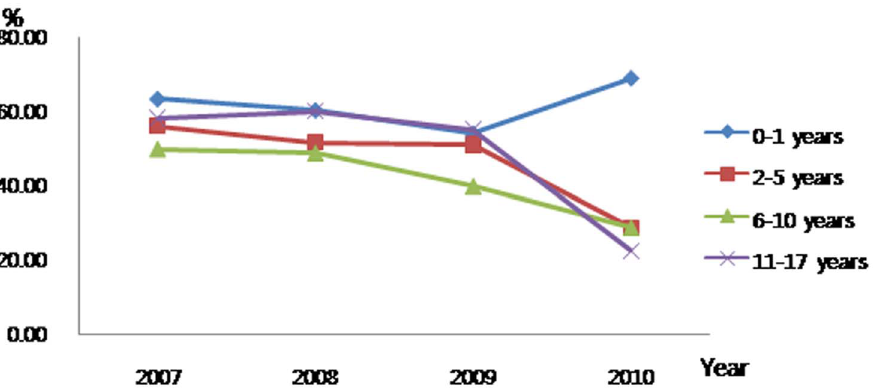
Figure 1. Trends for administering chemotherapy as aggressive end-of-life care to Korean pediatric cancer patients who died 2007– 2010.